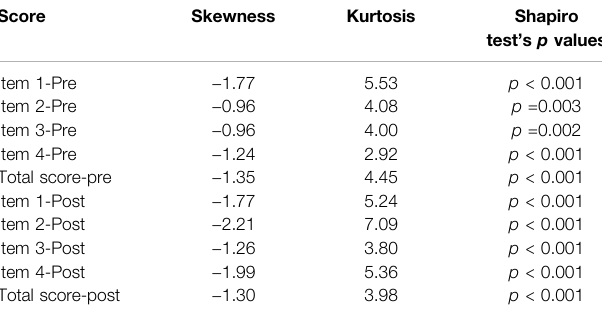
TABLE 2 | Skewness, kurtosis, and p values for normality Shapiro test. Score Skewness